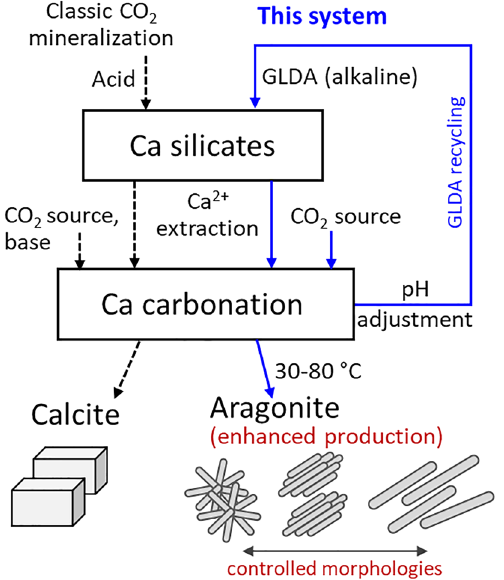
Figure 1. Schematics of GLDA-assisted aragonite production and comparison with a classic CO 2 mineralization